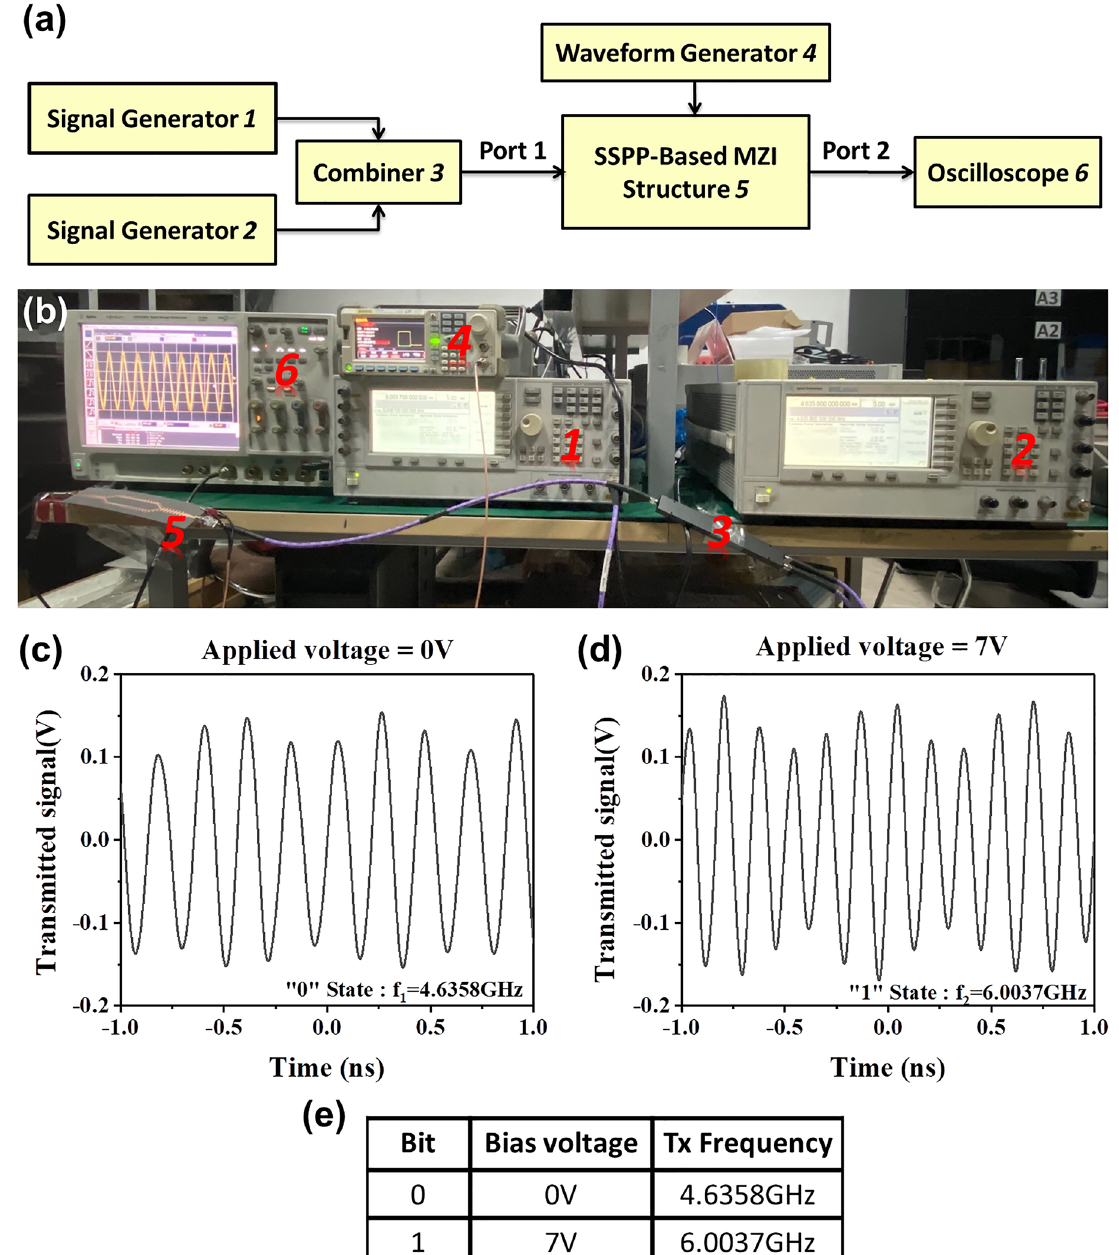
Figure 5: The setup of 2FSK modulation system and measured results. (a) The schematic diagram of measurement system. (b) Photo of the experimental setup. (c) – (d) The measured waveforms under the applied voltages of (c) 0 and (d) 7 V. (e) Table of correspondence among bit, bias voltage and Tx